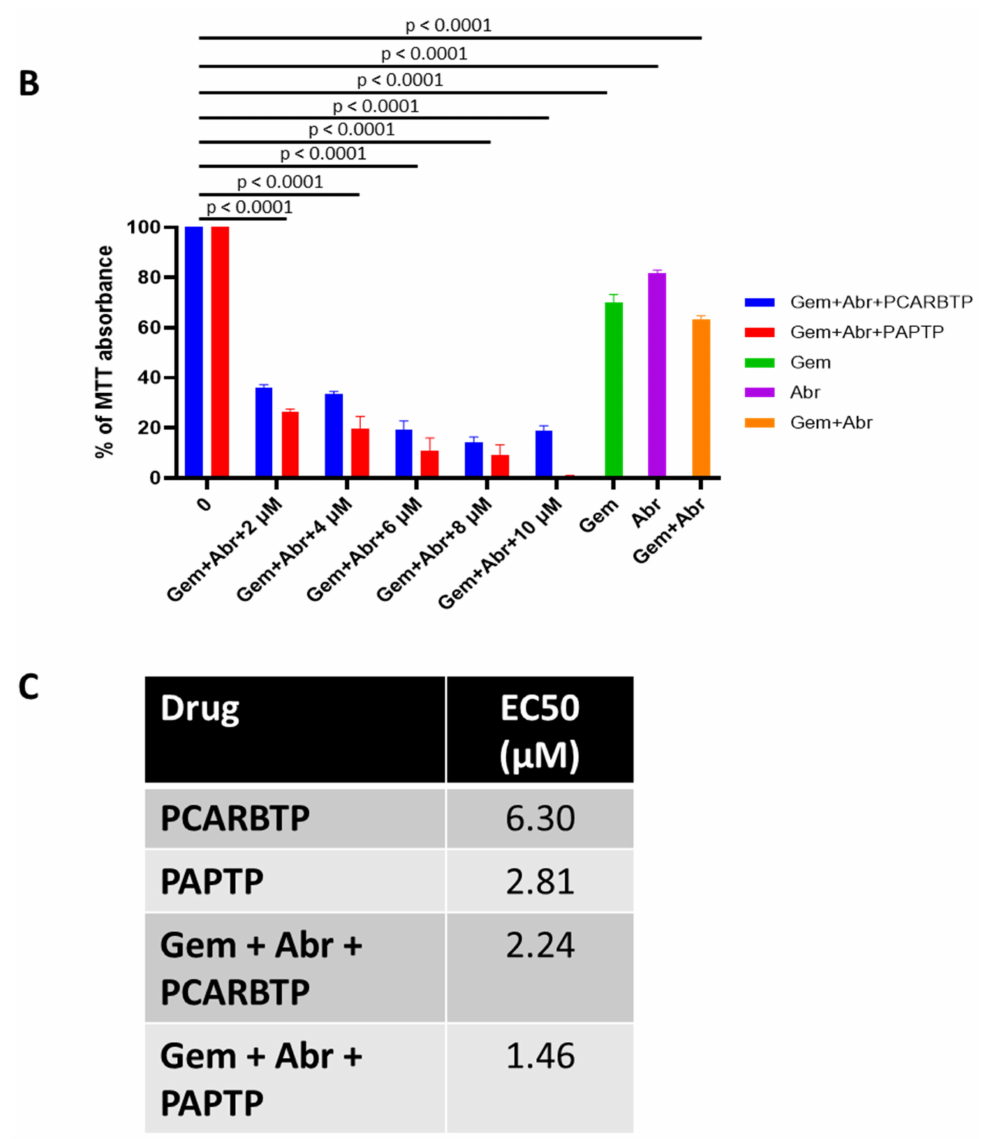
Figure 2. PCARBTP and PAPTP trigger apoptosis in Pan02 cells by enhancing mitochondrial ROS product and combination with Gemcitabine and Abraxane enhances tumor cell death. ( A ) MTT assay performed on Pan02 cells treated with PCARBTP / PAPTP or ( B ) combined with Gemcitabine and Abraxane as indicated ( n = 3, mean ± SD). ( C ) EC50 of PCARBTP and PAPTP alone and in combination Gemcitabine and